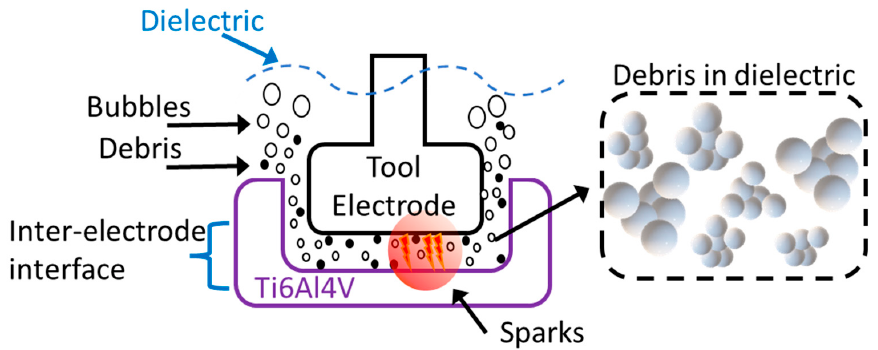
Figure 1. Schematic of the electric discharge machining process.